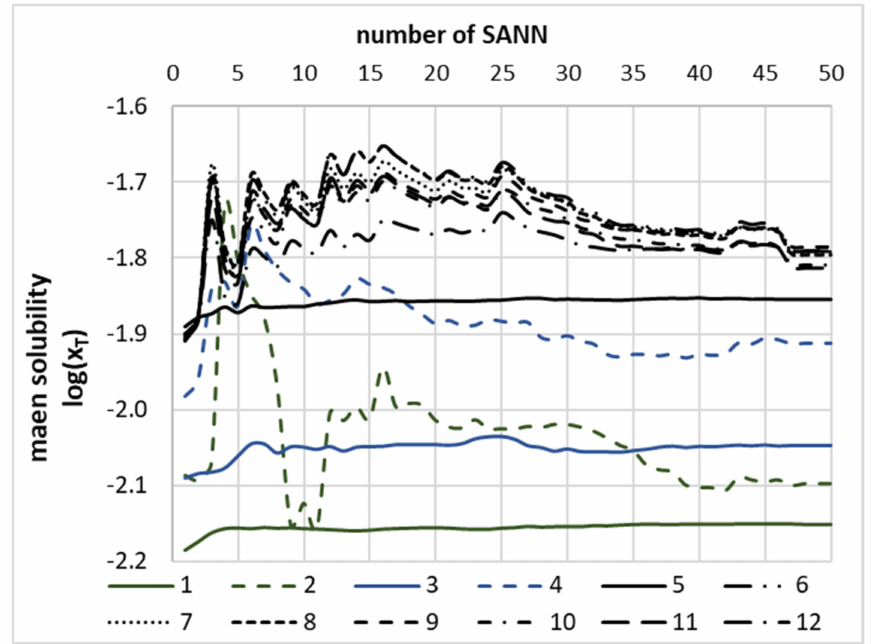
Figure 7. The distribution of mean values of theophylline solubility, expressed as the logarithm of mole fraction in the selected solvents, as a function of the number of neural networks taken for averaging. All accepted SANNs were sorted with decreasing accuracy. Legend caption: